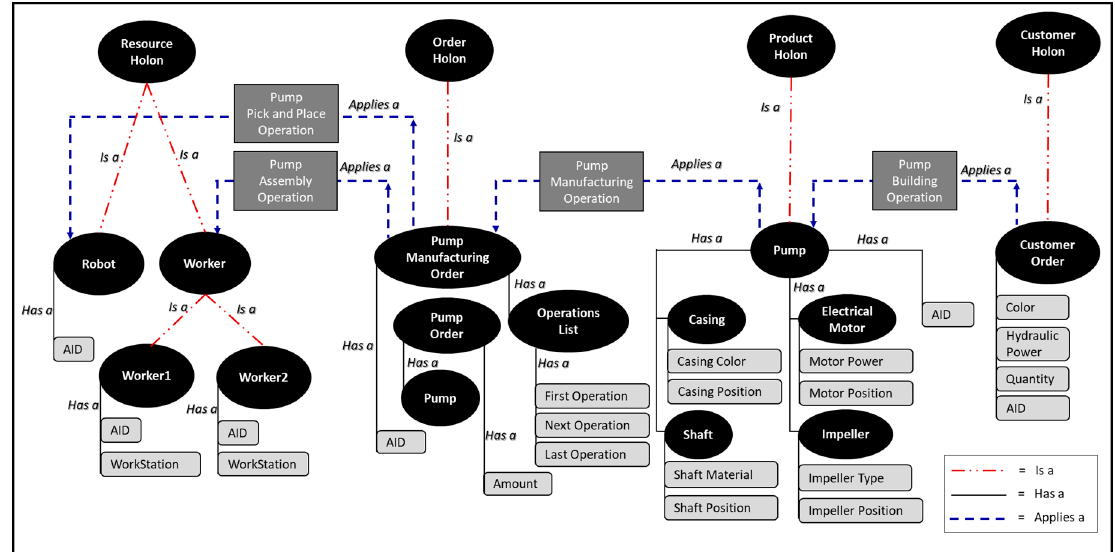
Figure 11. Case-Study Ontology.